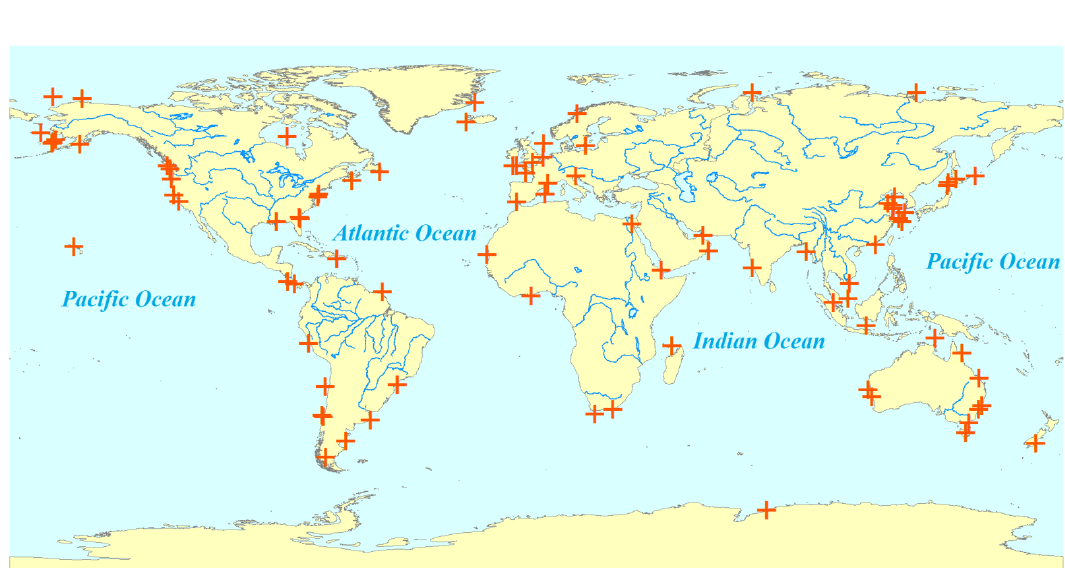
Figure 8. Distribution of continental shelves studied. 2 Fig. 8. Distribution of continental shelves 3